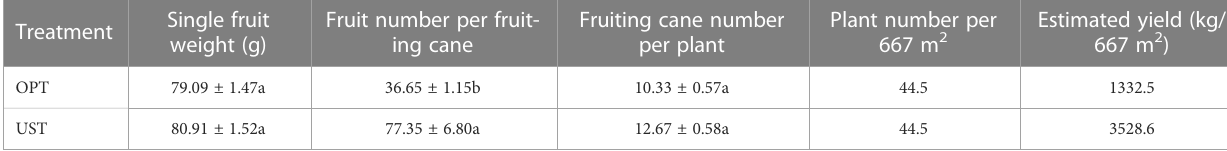
TABLE 1 Effects of the OPT and UST on the estimated yield of Donghong